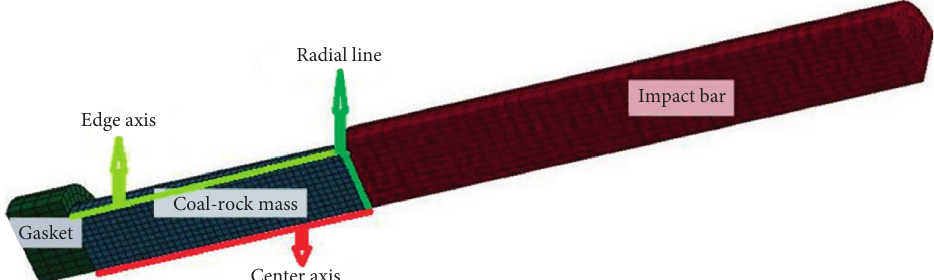
Figure 1: Schematic diagram of the HJC constitutive model.